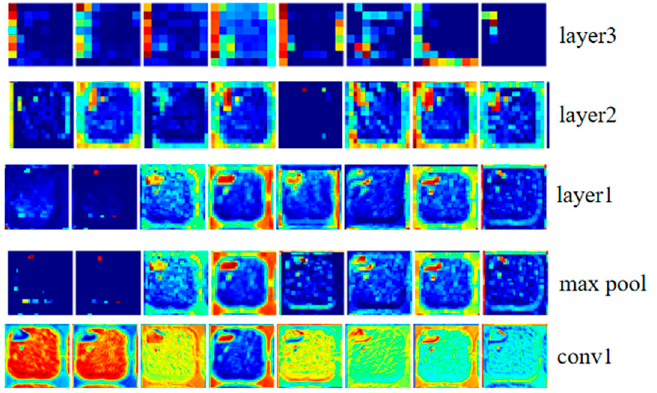
Figure 12. C haracteristics captured by the CBAM-ResNet45 model. Figure 12. Characteristics captured by the CBAM-ResNet45